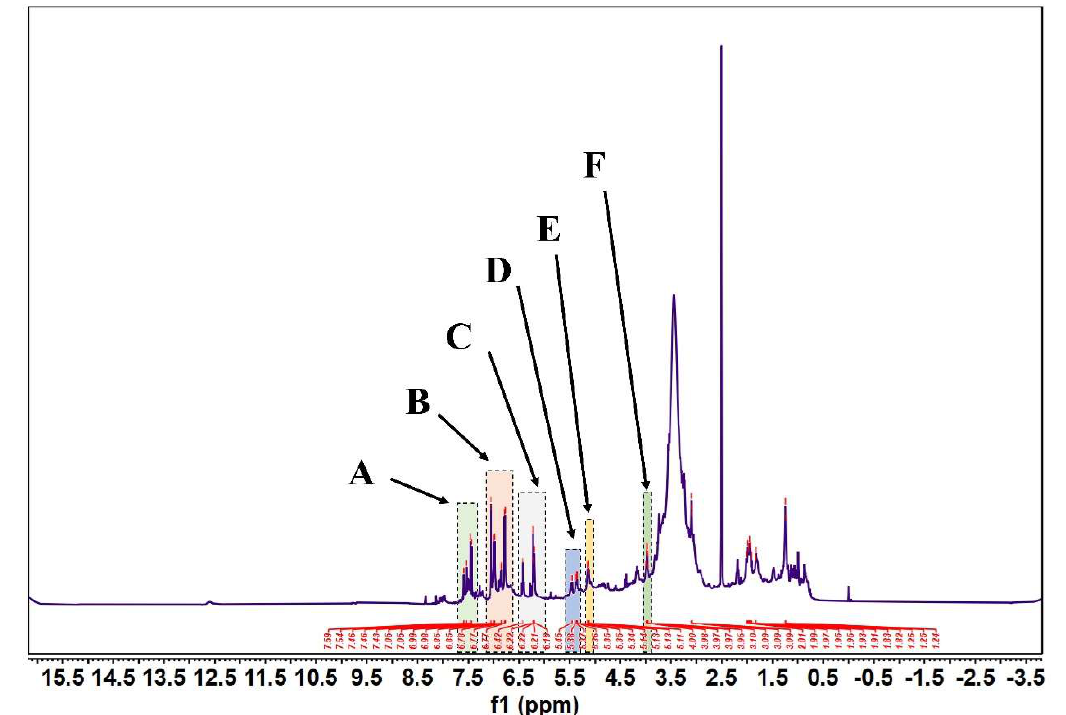
Figure 5. FML NMR hydrogen spectra (1H NMR). (Note: FML had six heterotopic hydrogen signals at δ7.43~7.59(part A), 6.77~7.05(part B), 6.19~6.42(part C), δ5.34~5.45(part D), 5.11~5.14(part E), and 3.95~4.00(part F) ppm in 1H-NMR).